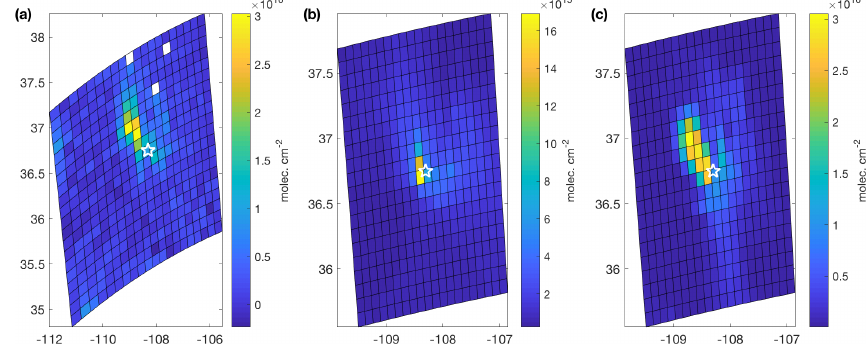
Figure 4. A comparison of OMI SCDs (a) and WRF monthly average (b) and daily (c) VCDs. The star marks the location of the Four Corners power plant. Data are from 4 March 2007.